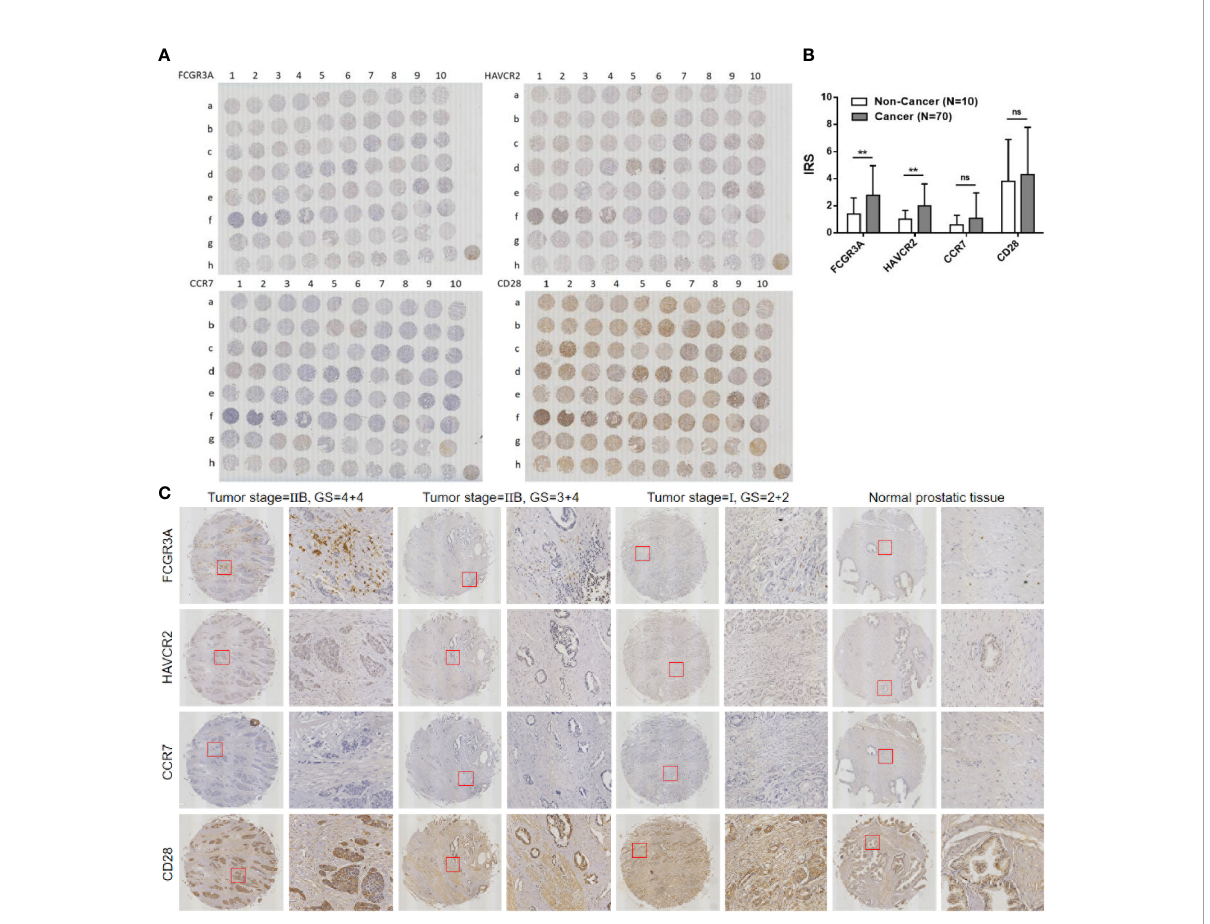
FIGURE 4 Immunohistochemical staining for 4 target genes expression in PCa and normal prostate tissue samples. (A) Full view of the immunohistochemistry staining for 4 target genes expression. (B) (no signi fi cance, ns P>0.05) Immune risk score (IRS) of 4 target genes in PCa and normal prostate tissue samples (Cancer vs. Non-Cancer, ** P <0.01). (C) 4 target genes expression in PCa tissue samples with different tumor stages and Gleason score